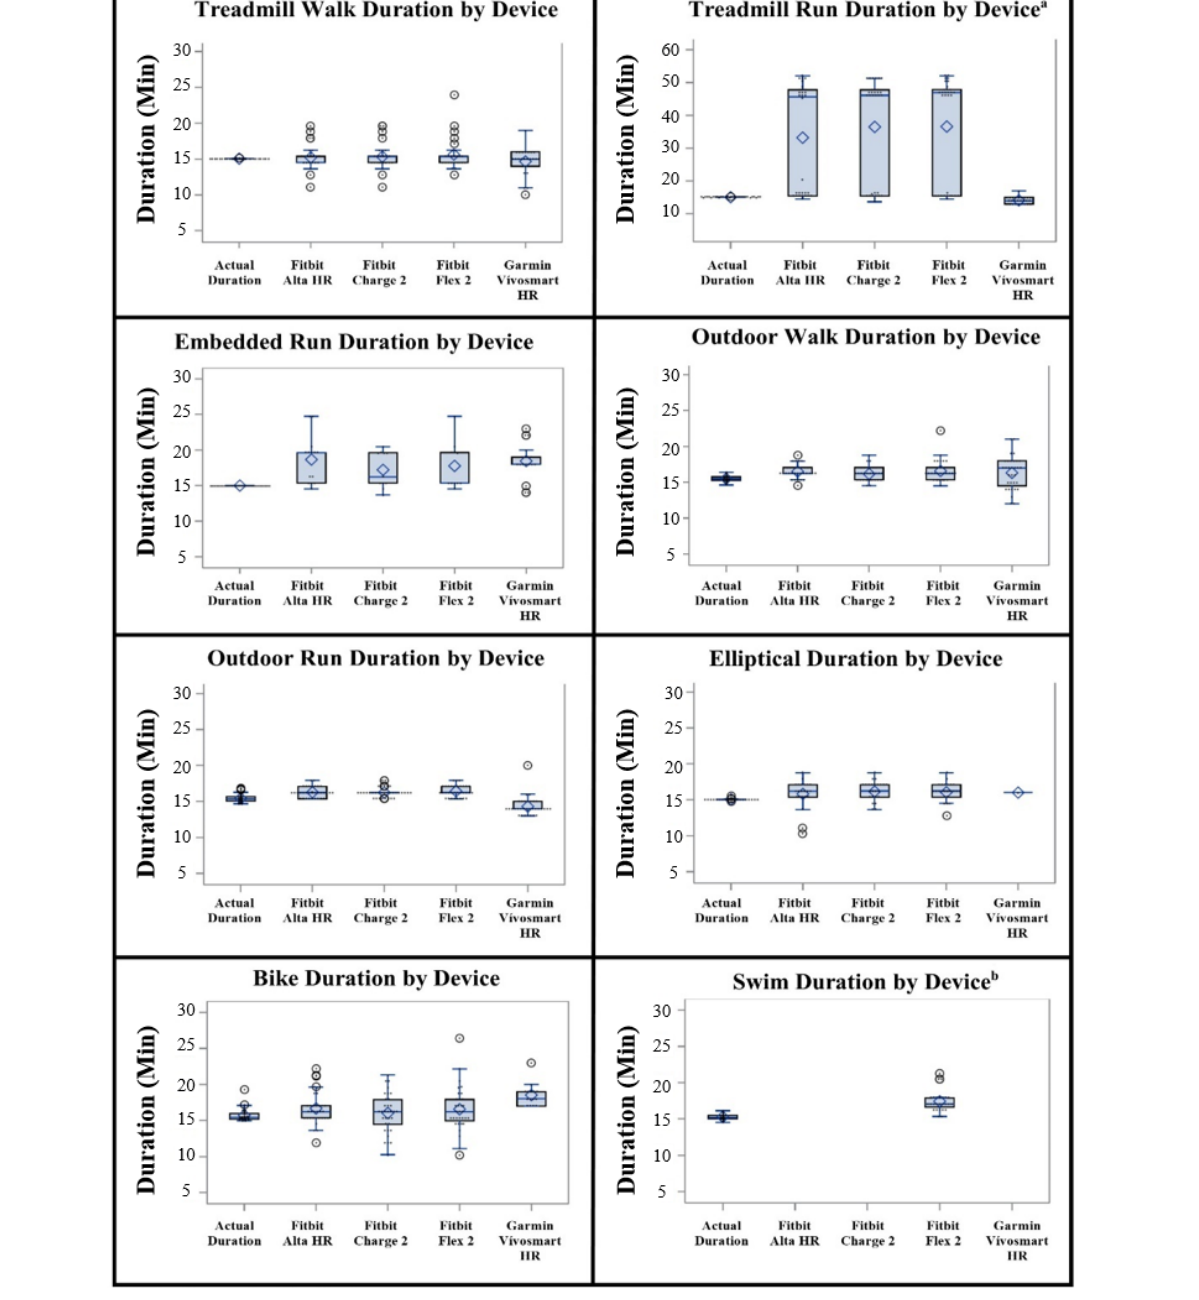
Figure 2. Box plots of the actual duration of each activity, compared to the duration estimated by the automatic activity recognition feature on each of the four